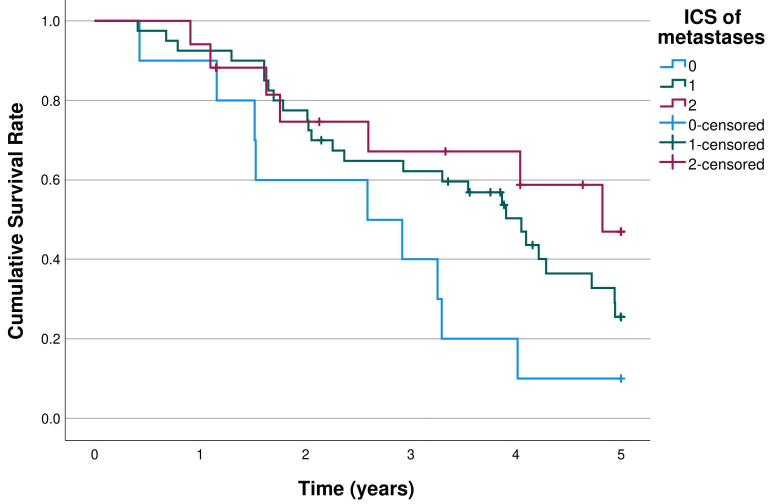
Figure 3. K m curves of 5-year survival of first pulmonary metastasectomy stratified by ICS of pulmonary metastases ( n = 67). Log rank p = 0.046. Table 2. 5-year survival rates in pulmonary metastases and 10-year survival rates in primary colorectal tumours stratified by ICS and PD-1 and PD-L1.